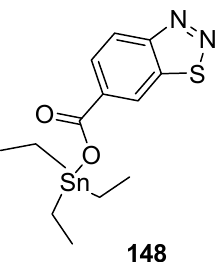
149 ( Figure 32) displayed